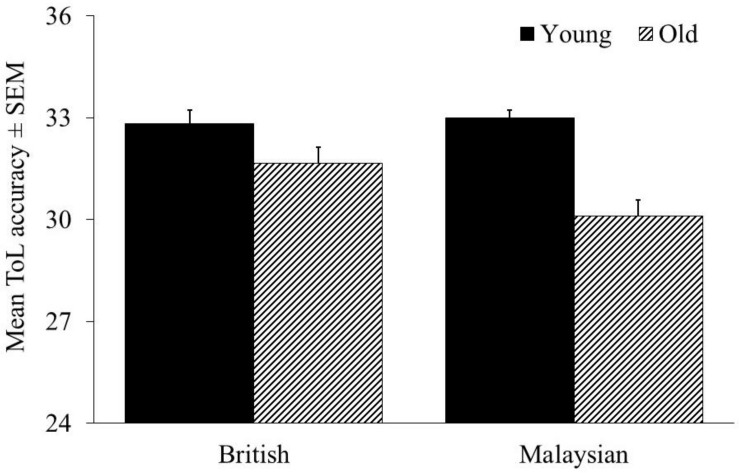
ToL accuracy for the British and Malaysian participants.